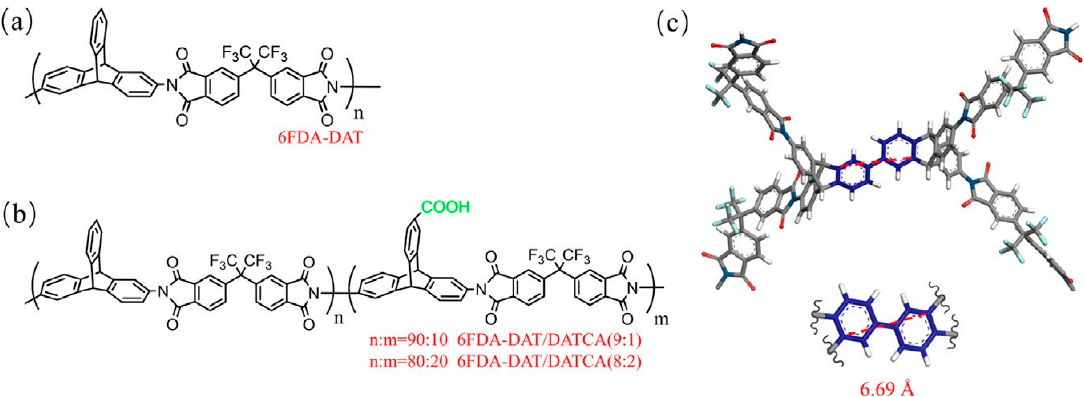
Figure 5. Chemical structures of ( a ) 6FDA-DAT; ( b ) 6FDA-DAT/DATCA; and ( c ) estimated distance (6.69 Å) between the crosslinked chain segments of 6FDA-DAT/DATCA (energy of chain conformations was minimized using Material Studio 7.0) [60]. Processes 2018 , 6 , x FOR PEER REVIEW